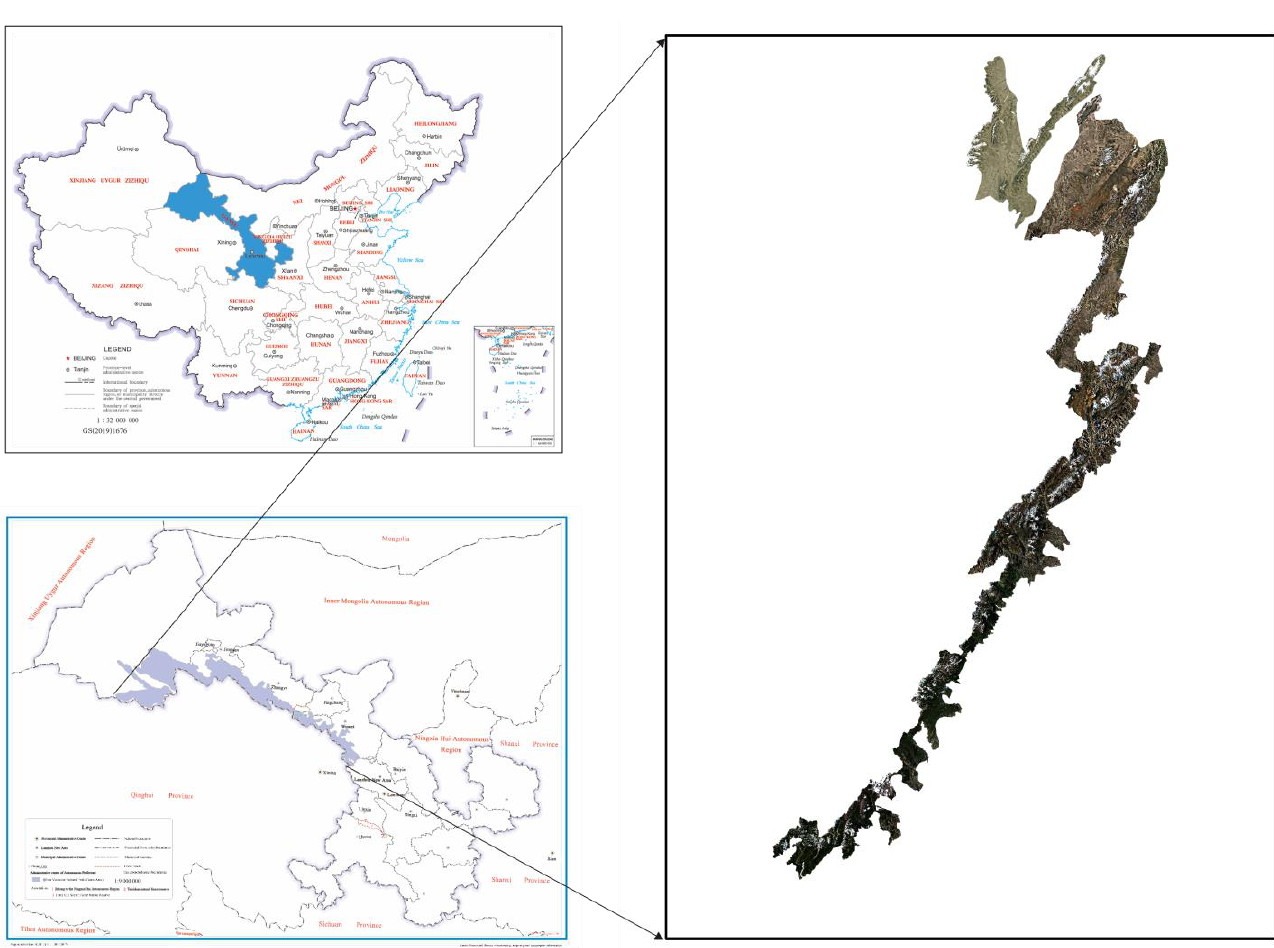
Table 1. Statistics of major indicators of Qilian Mountain National Park (Gansu Area) in 2019.